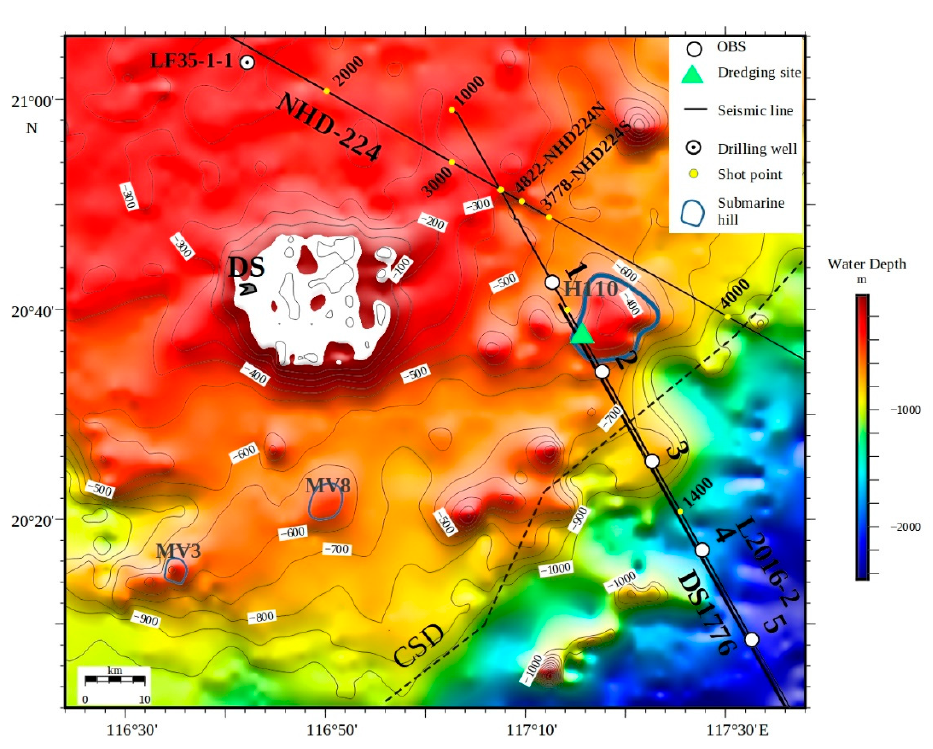
Figure 2. Bathymetry map of the DS waters (topographic data in 15 ″ × 15 ″ were downloaded from ftp://topex.ucsd.edu/pub/srtm15_plus/topo15.grd (accessed on 1 October 2014)). Hill MV3 and Hill MV8 were previously recognized mud volcanoes [12].